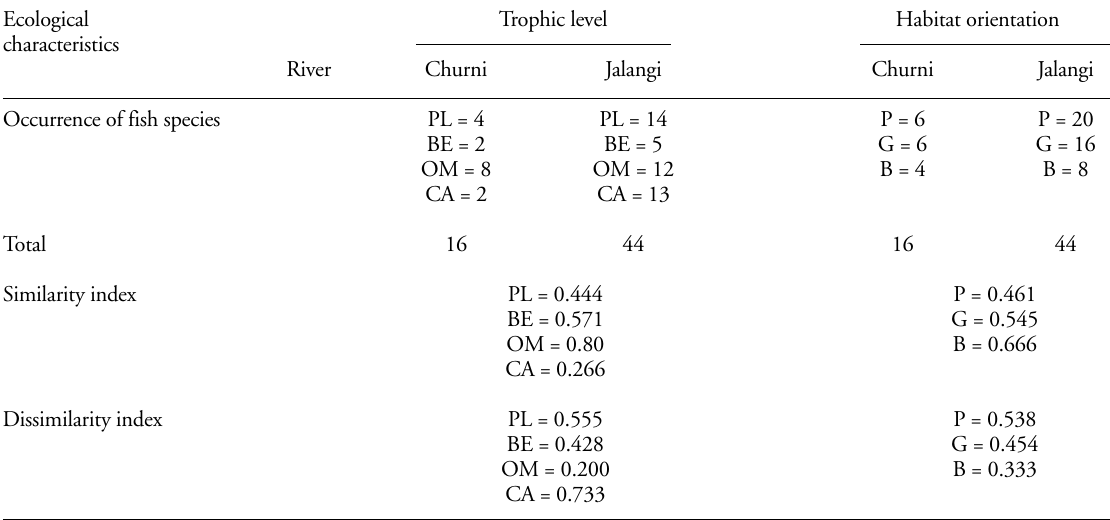
Table 2. Data regarding trophic level, habitat orientation, similarity and dissimilarity indices.